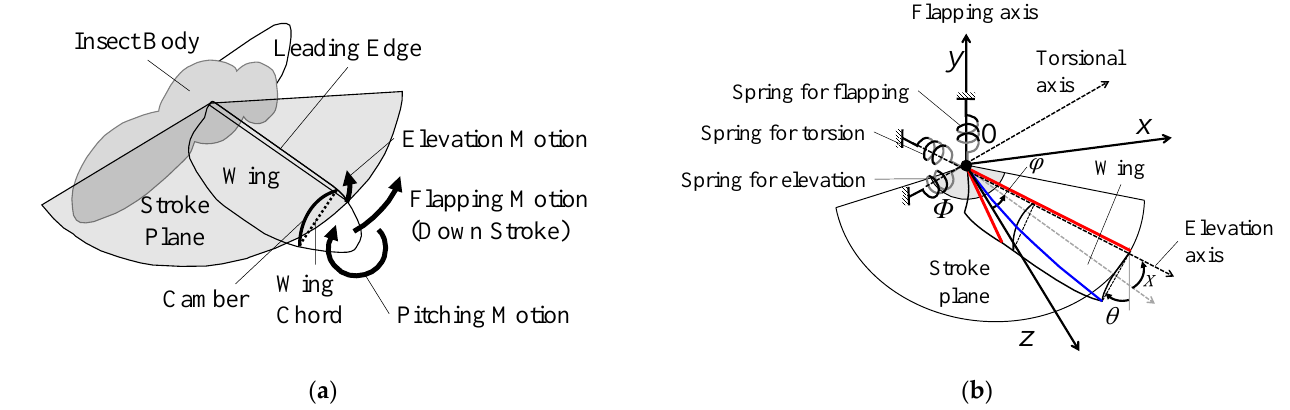
Figure 1. Modeling of the insect flapping wing: ( a ) Schematic view of the insect flapping wing; ( b ) The basic model wing for the FSI design with the springs of flapping, torsion, and elevation, which correspond to the axes of flapping, torsion, and elevation, respectively. Φ is the stroke angle, φ is the stroke angular displacement, θ is the pitching angular displacement, and χ is the elevation angular displacement.